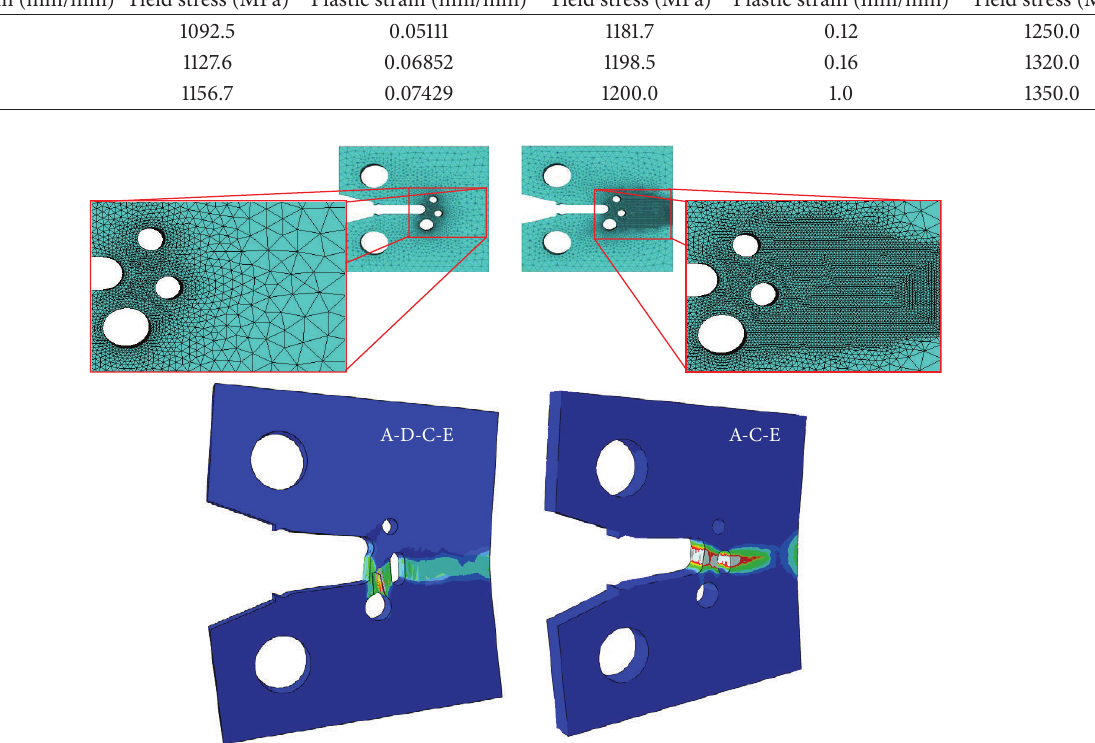
Figure 3: Influence of mesh refinement on predicted crack